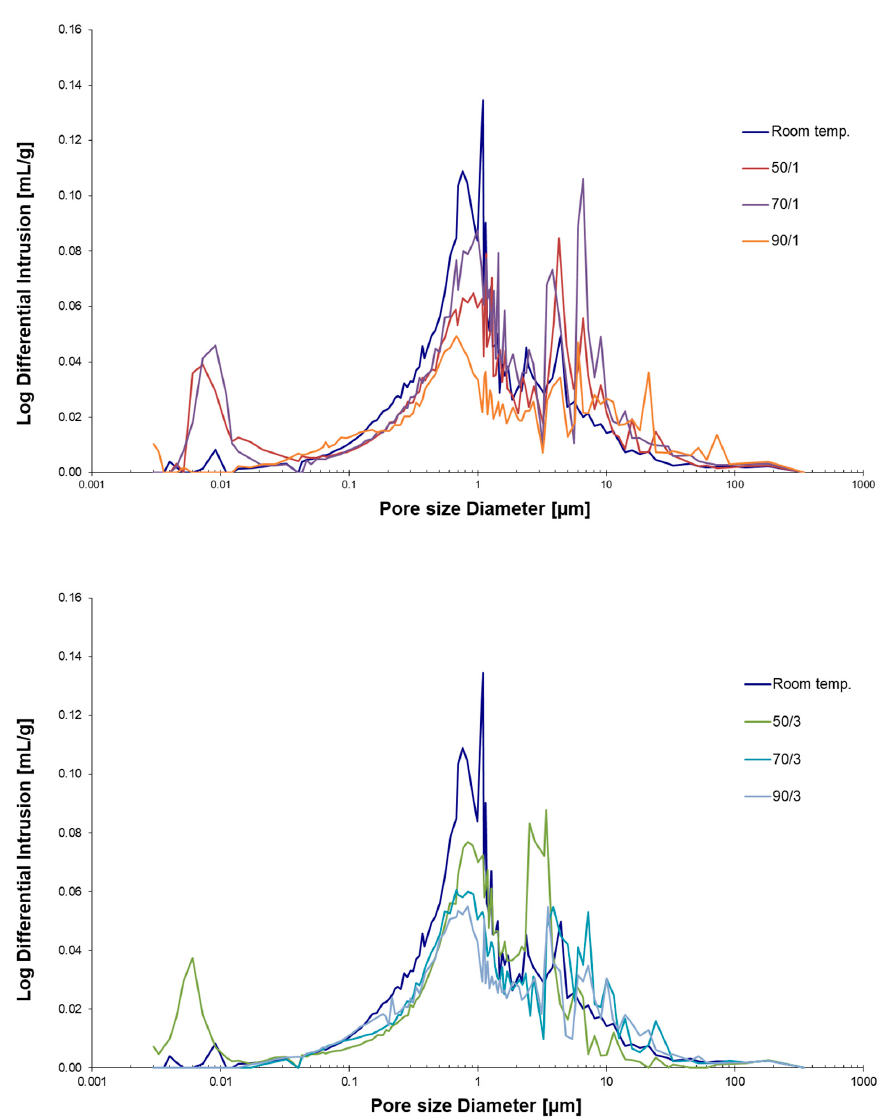
Figure9. Di ff erentialmercuryintrusionporosimetryofA / R:1 / 1specimencuredatdi ff erenttemperatures (R.T., 50, 70, 90 ◦ C) for one ( above ) or three days ( bottom